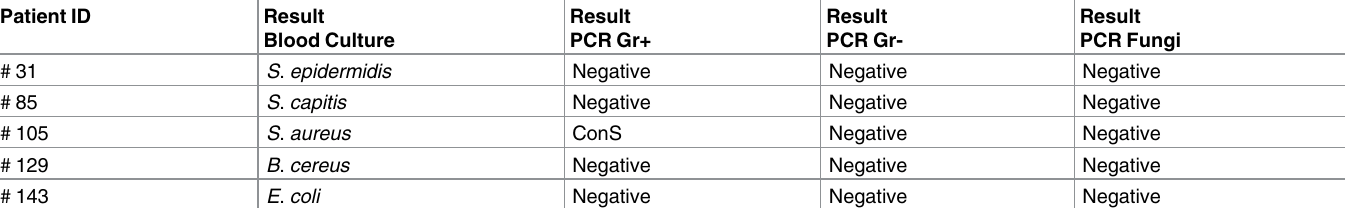
Table 3. Positive blood cultures missed by SeptiFast MGRADE